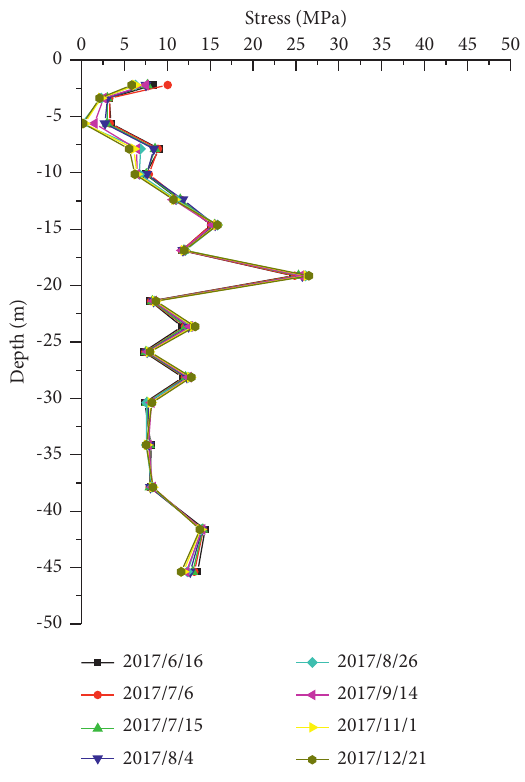
Figure 10: The body stress of 29# antislide pile during the